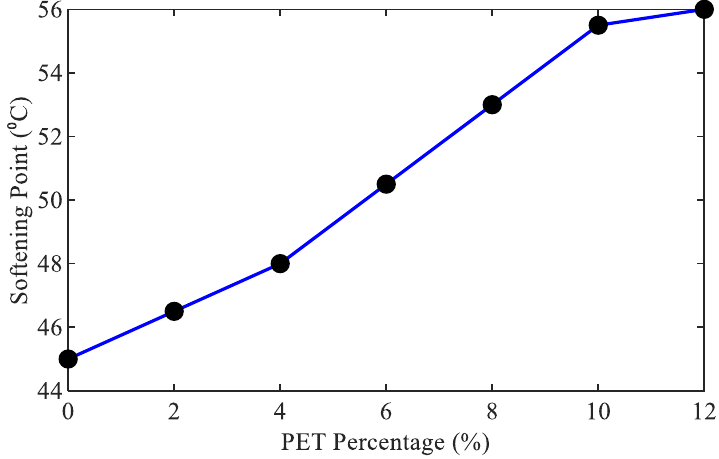
Fig. 16 Effect of PET on softening point of bitumen